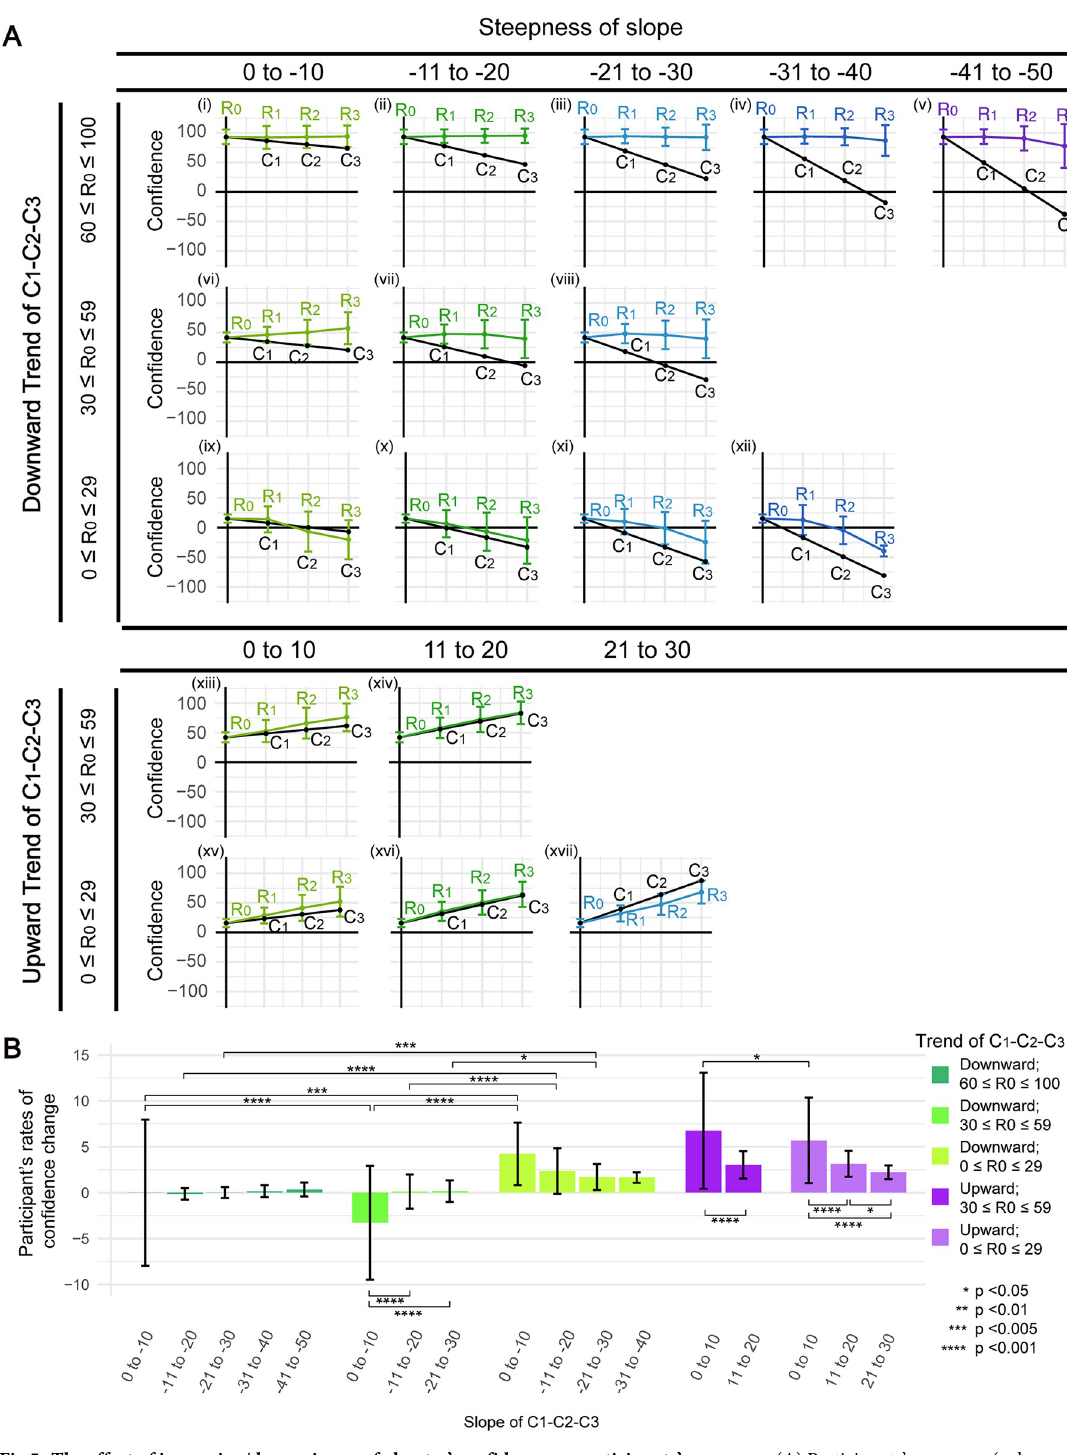
Fig 5. The effect of increasing/decreasing confederates’ confidence on participants’ responses. (A) Participants’ responses (colour lines, mean ± SD) across sessions with different levels of initial confidence and trends of confederate values. Participants are further grouped based on their average slope of C 1 - C 2 and C 2 - C 3 , represented by the black lines. Data with R 0 < 0 were flipped in the three sessions as in Fig 3C. (B) Participants’ rates of confidence change (mean ± SD) in the three confederate sessions (see Materials and methods). Significantly differences (pair-wise t test) are marked by stars. From left to right, n = 173, 281, 86, 162, 130, 79, 175, 38, 7, 312, 98, 2, 103, 84, 126, 379, 104.